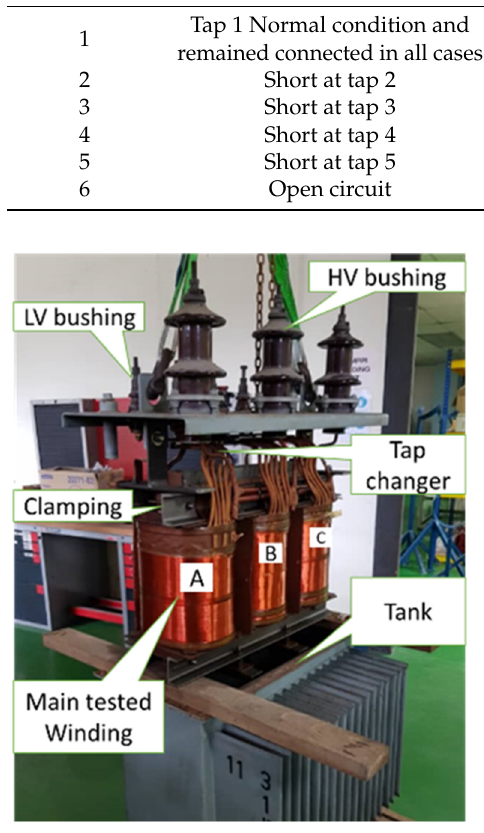
Figure 1. Tested distribution transformer windings.